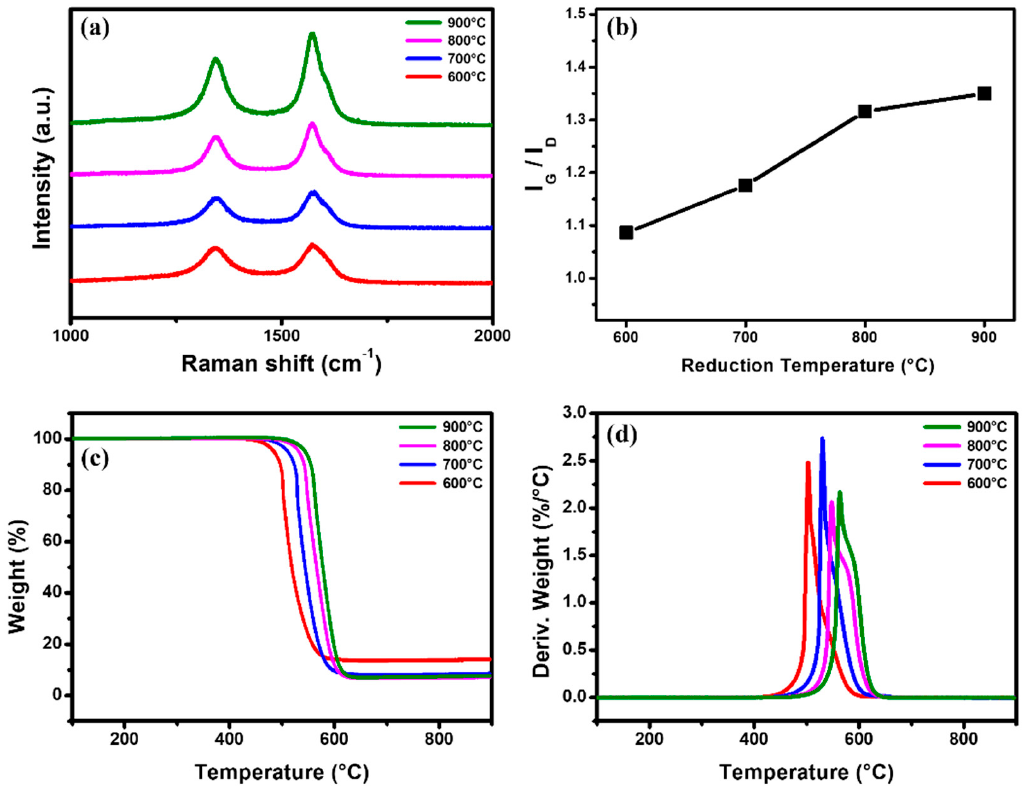
Figure 7. ( a ) Raman spectroscopy ( b ) I G /I D ratio ( c ) thermogravimetric analysis (TGA) and ( d ) derivative thermogravimetric (DTG) analysis of MWCNTs according to reduction temperature of Fe–Co/MgO catalyst.